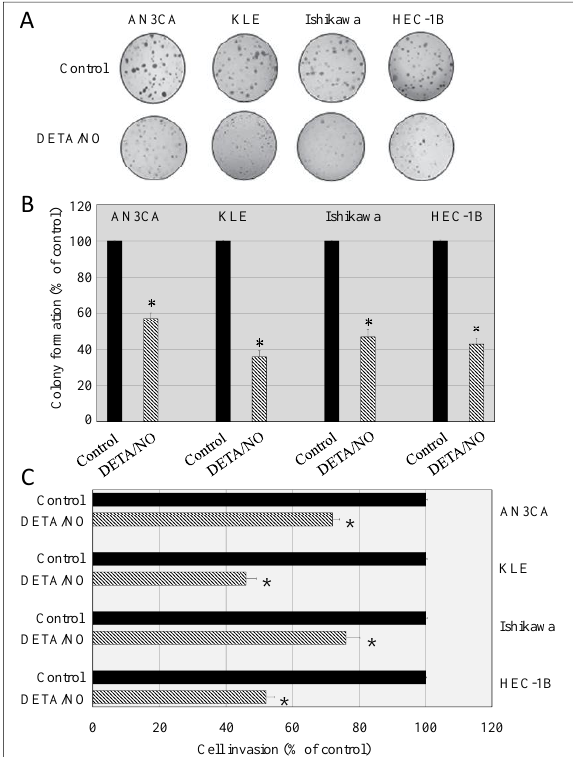
Figure 5. DETA / NO decreased the colony formation and invasion of cancer cells. ( A ) AN3CA, KLE, Ishikawa, and HEC-1B vehicle or DETA / NO-treated cells were cultured on soft agar and imaged to examine their colony-forming ability. ( B ) Number of colonies on soft agar were counted. Bars are mean ± SEM and * indicates a statistically significant di ff erence ( p < 0.05). ( C ) The number of cells that migrated through the Matrigel was counted following 22 h of plating. Data are mean ± SEM of six wells and * indicates a statistically significant di ff erence ( p < 0.05) between control and treated cells.